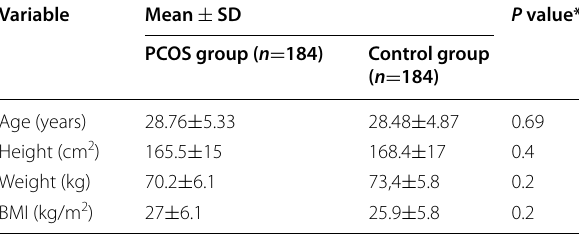
SD standard deviation, PCOS polycystic ovary syndrome, *significant difference at P <